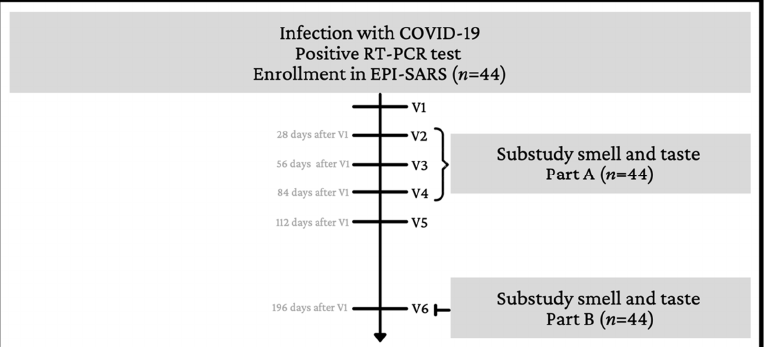
Figure 1. Flow chart showing the structure and links between the parental study (EPI-SARS study) and the substudy on smell and taste. RT-PCR positive tested individuals were included in the study and followed over the course of 6 months, with repeat blood sampling and questionnaires